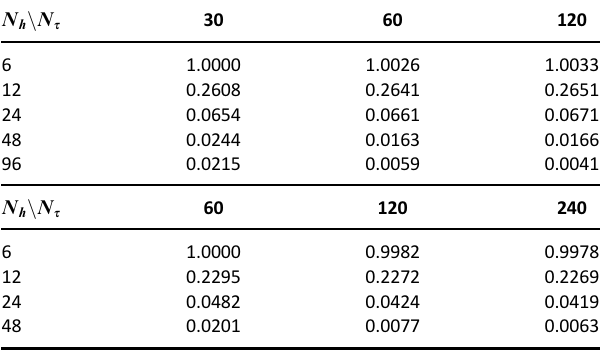
Table 1. (Time space convergence of dias for linear elements, cf. the section Convergence tests ) The approximation error e pcg hNh ; s N s with ρ ref ¼ q p 2 scaled by the inverse of e p 1 ¼ 1 : 119 (cid:4) 10 (cid:3) 1 h 96 ; s 120 h 6 ; s 30 (top) and e p 2 ¼ 3 : 201 (cid:4) 10 (cid:3) 2 (bottom) for varying space and h 6 ; s 60 time discretizations and for polynomial degree cg ¼ 1 (top) and cg ¼ 2 (bottom) for Test Case 1. Cf. also Figure 3a and b illustrating the convergence in space for the finest time discretization (the rightmost columns in the tables).